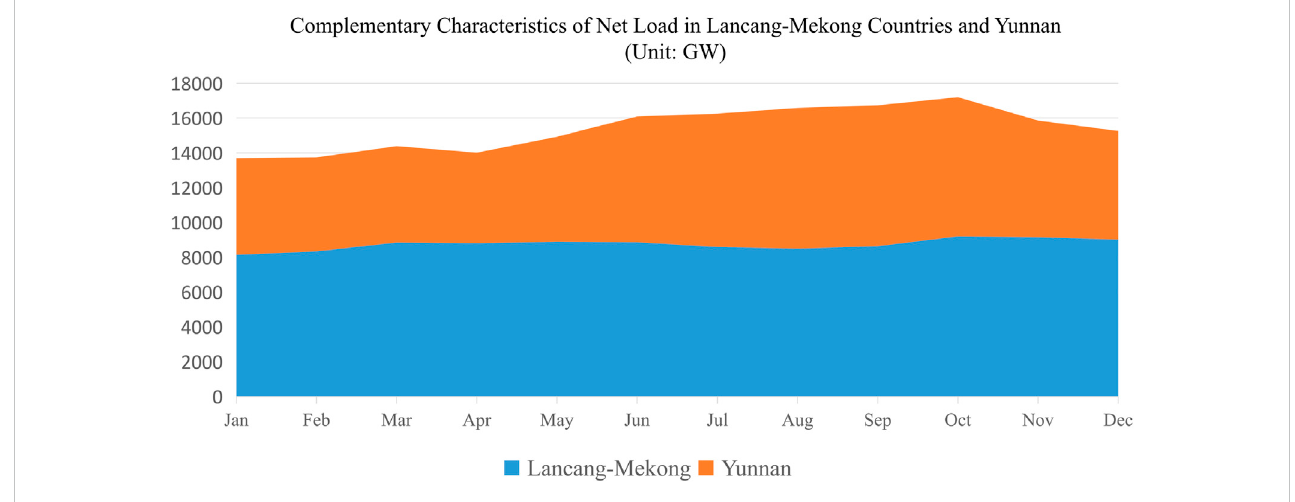
FIGURE 5 Complementary characteristics of net load in Lancang- Mekong countries and